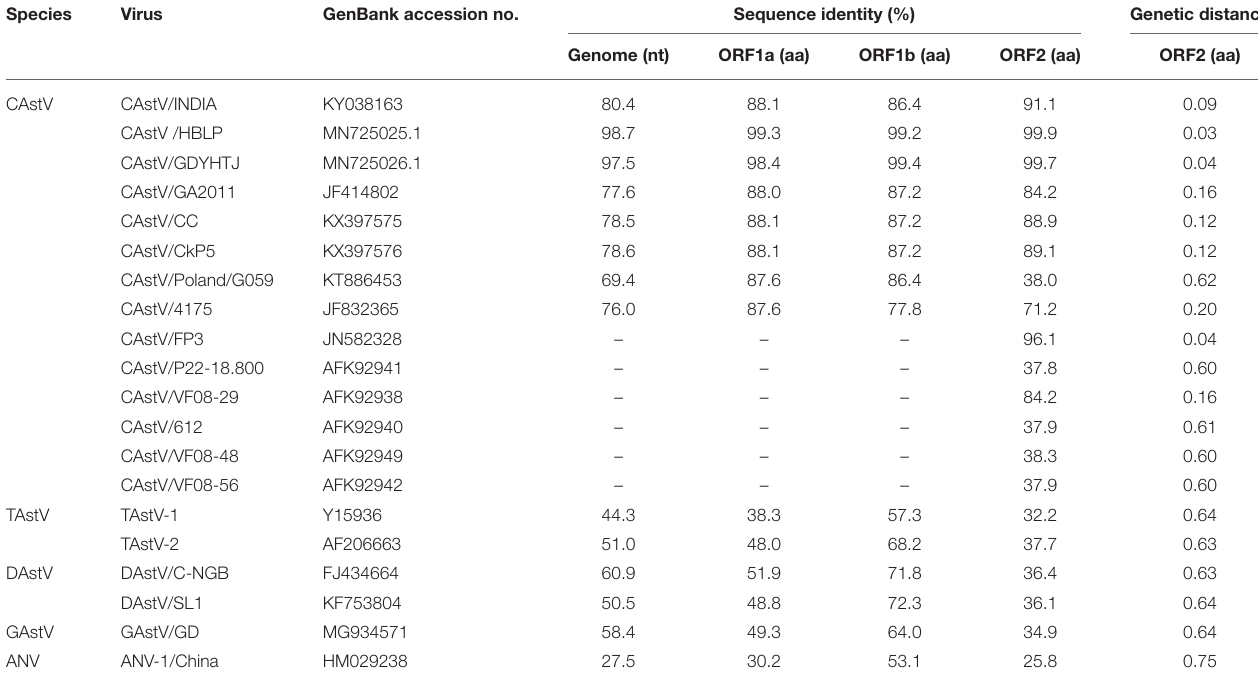
TABLE 2 | Comparisons of nucleotide and amino acid sequences of CAstV NJ1701 with selected representative astroviruses. Species Virus GenBank accession no. Sequence identity (%) Genetic distance Genome (nt) ORF1a (aa) ORF1b (aa) ORF2 (aa) ORF2